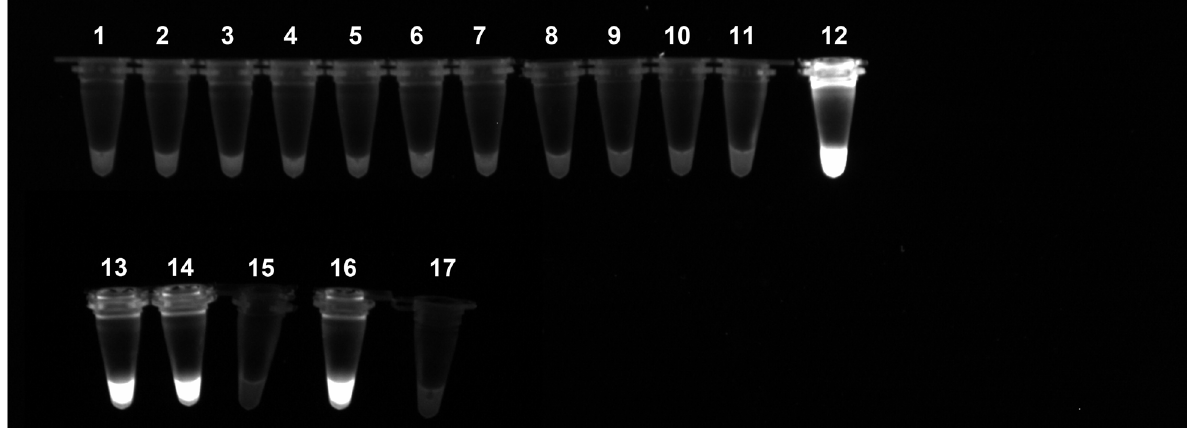
Fig 3. Specificity of the PI-LAMP. The micro-tubes containing the reaction mixture with propidium iodide have been exposed to UV after incubation. The positive reactions that returned an amplification product are evidenced by a bright fluorescence. The reaction have been performed by using purified DNA from larvae of 1) Acanthocheilonema reconditum ; 2) Acanthocheilonema sp.; 3) Angiostrongylus vasorum ; 4) Brugia sp.; 5) Cercopithifilaria sp.; 6) Dirofilaria immitis ; 7) Loa ; 8) Mansonella perstans ; 9) Spirocerca lupi ; 10) Wuchereria bancrofti ; 12) and 13) Dirofilaria repens ; 14) D . repens positive mosquito pool; 15) D . repens negative mosquito pool; 16) D . repens positive canine blood; 17) D . repens negative canine blood. The sample 11 is a negative sample with water instead of